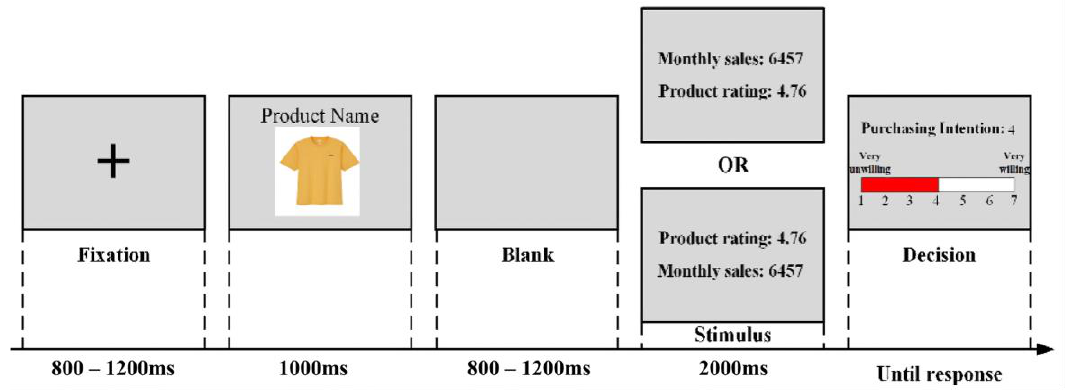
Figure 1. Experiential